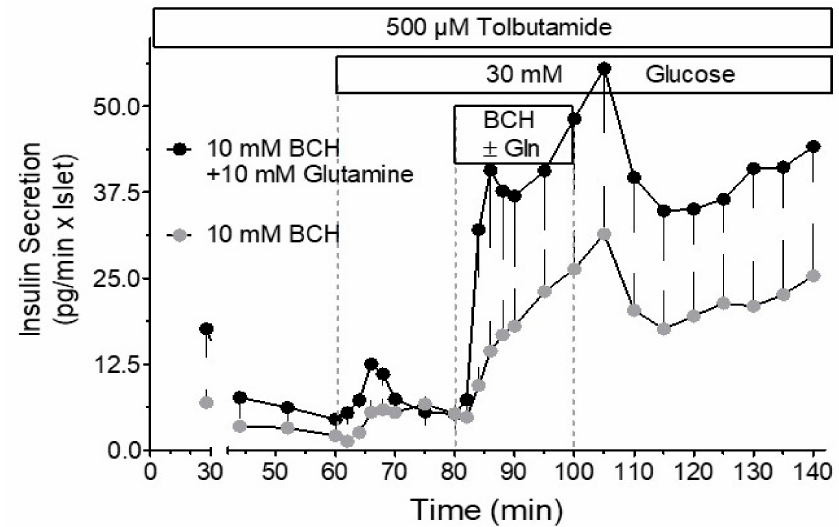
Figure 3. The rescue of the metabolic amplification of glucose, abolished by a period of depolarization in the absence of nutrients. The amplification was restarted by perifusion with BCH and continued after wash-out of BCH. The concomitant presence of glutamine and BCH resulted in a virtual jump- start. Again, the elevated secretion level continued after wash-out of the starters. Since tolbutamide depolarizes beta cells even in the absence of glucose, the triggering signal is continuously present. For the underlying mechanisms, see Figure 4. Adapted from Reference [47].